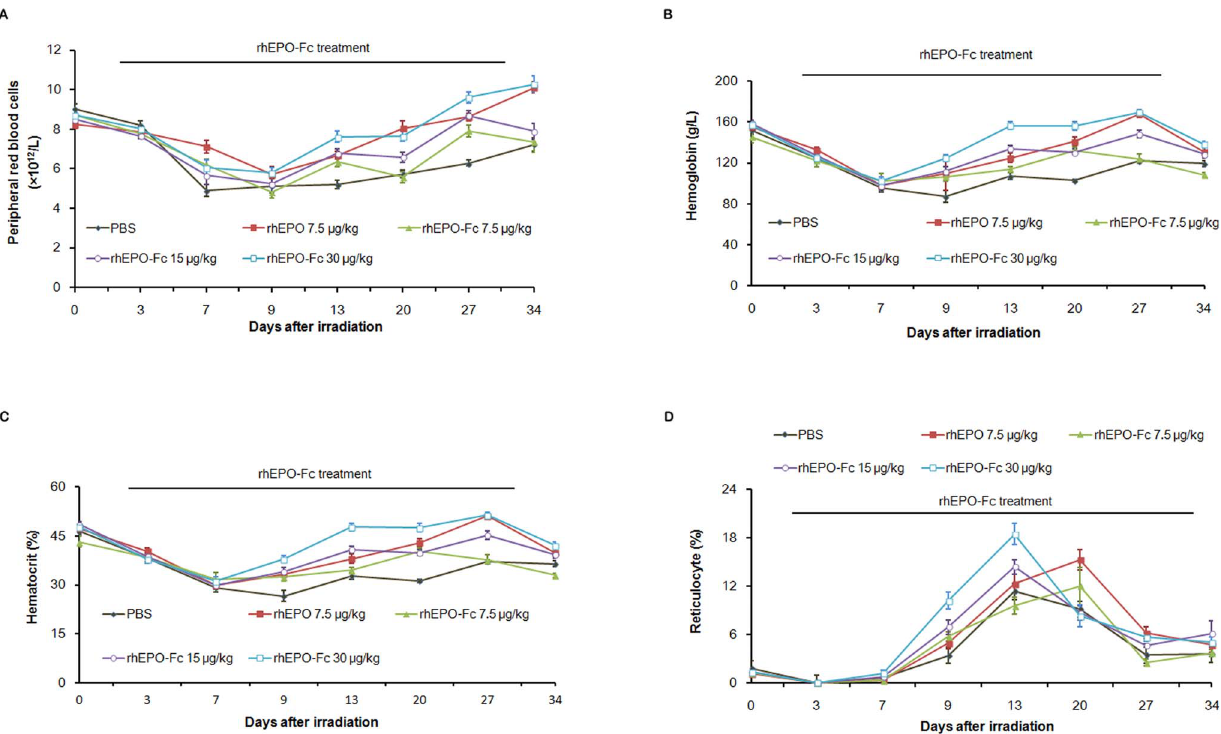
Figure 2. rhEPO-Fc attenuated anemia induced by irradiation in mice. Blood samples were taken at day 0, 3, 7, 9, 13, 20, 27 and 34 to determine RBC (Fig. 2A), hemoglobin (Fig. 2B), hematocrit (Fig. 2C), and reticulocyte (Fig. 2D). Data were presented as Mean 6 SD.